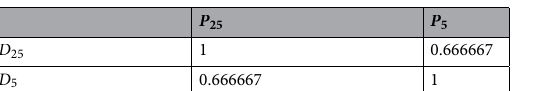
Table 2. NMI between detected communities and planted communities for the ring-of-rings-of-rings. In the most left column, D 25 and D 5 symbolize sets of 25 and 5 communities detected from the network for α = 1.0651 and 3.2512 (indicated by the vertical dotted lines with numerals ‘25’ and ‘5’ in Fig. 6d), respectively. In the top row, P 25 and P 5 symbolize sets of 25 and 5 communities constituting the first and second layers of the planted hierarchy,